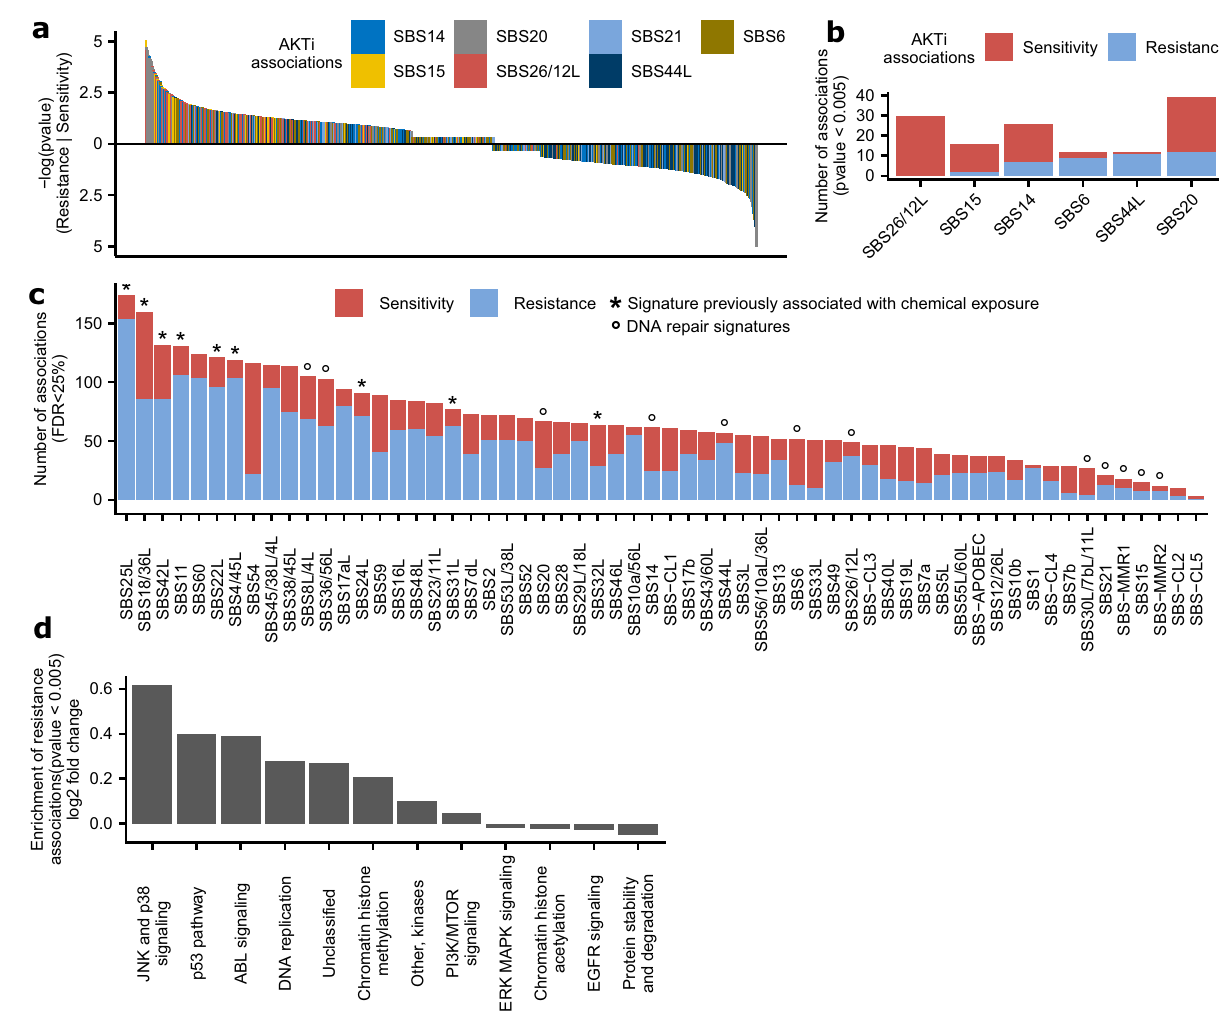
Fig. 5 Highlighted examples of robustly supported associations involving mutational signatures. a All tested associations between AKT inhibitors and DNA mismatch repair mutational signatures, across all three replication tests (by the “ two-way ” randomization test, see Methods section). Each bar represents a p -value of one association. For associations with effect size <0.2, p -values were not calculated in the randomization procedure and are here shown as having p = 0.5. b Associations having p < 0.005 between AKT inhibitors and individual DNA mismatch repair signatures. c The tally of signi fi cant associations at FDR < 25% across all three replication tests. The * and ° symbols denote groups of mutational signatures; see key embedded within the panel. d The average log2 ratio of observed vs. expected frequencies of occurrence of drug target pathways in resistance associations ( p -value < 0.005) with signatures of chemical exposure, over the top 6 signatures by the number of resistance associations (SBS25L, SBS18/36L, SBS42L, SBS11, SBS22L, and SBS4/45L). Source data are provided as a Source Data fi